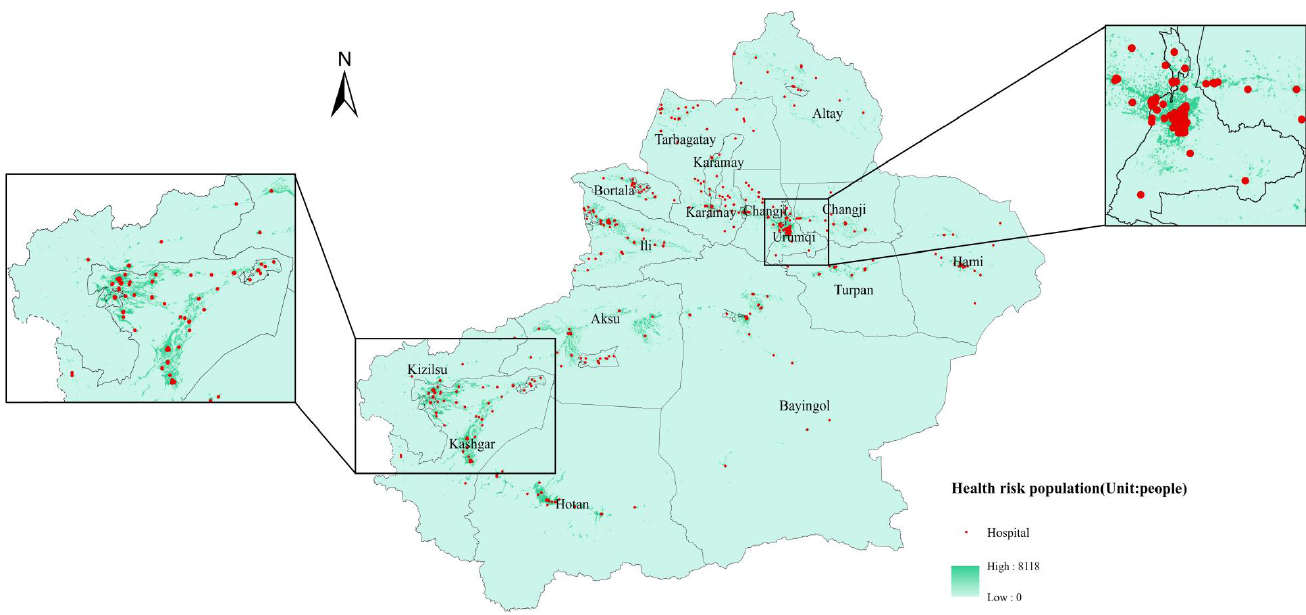
Figure A2. Spatial distributions of population, health risk population, and hospitals: spatial distribution of health risk population and hospitals.